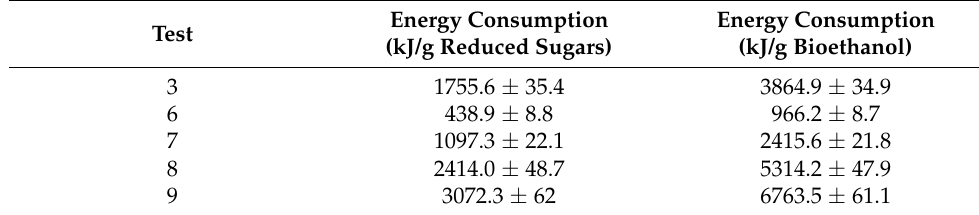
Table 3. Energy consumption at different